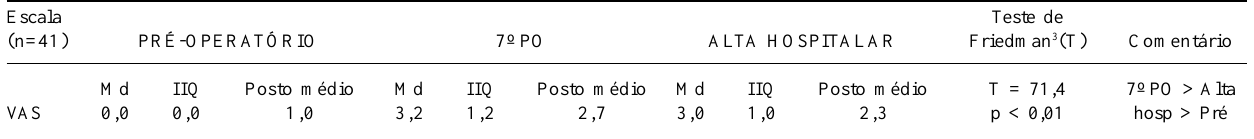
Tabela 2. Medidas de posição e dispersão, resultados dos testes e comentário, nos momentos pré-operatório, 7º dia pós-operatório (7º PO) e alta hospitalar, relativos à intensidade de